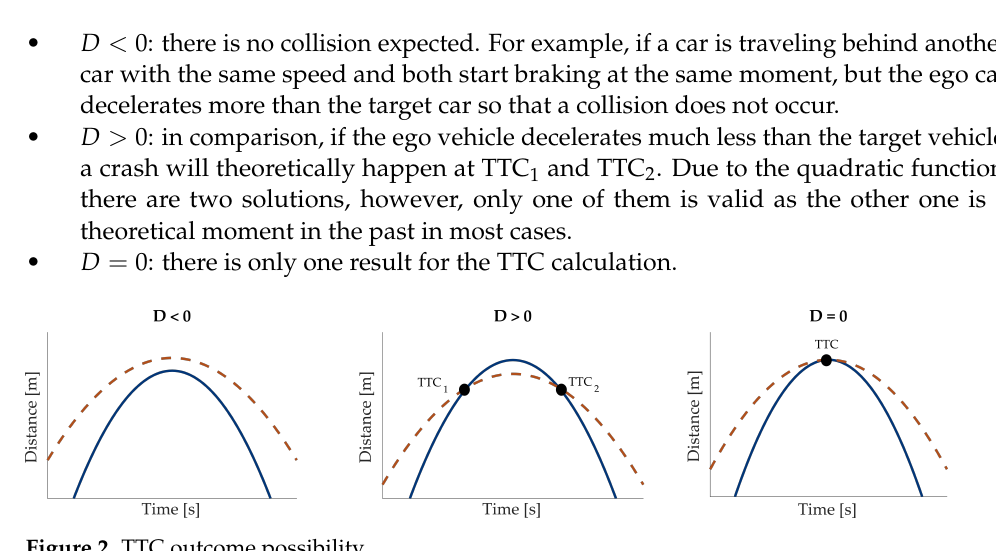
Figure 2. TTC outcome